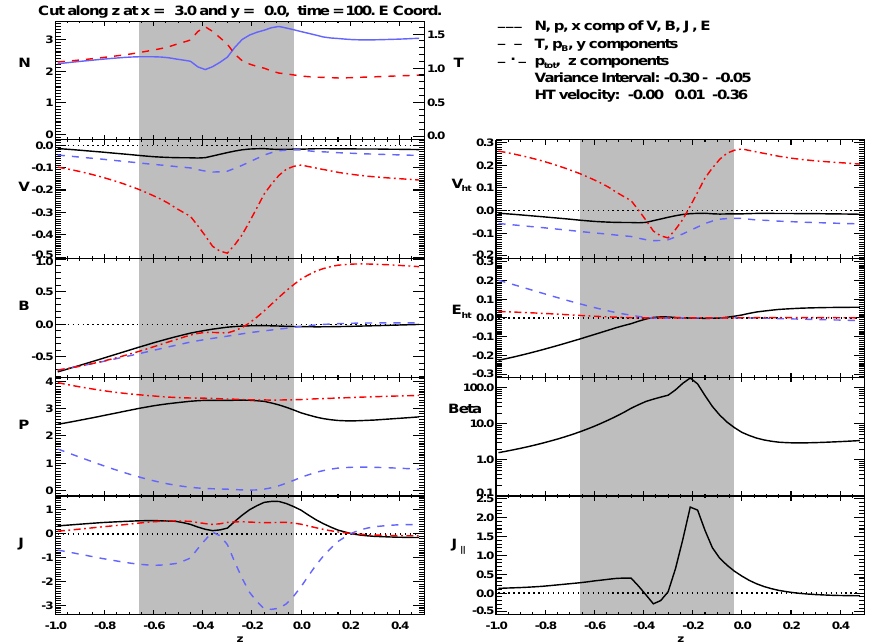
Fig. 14. Plasma parameters transformed into the basis given by MVAE for the outer boundary between the CDC and magnetosheath at x = 2 .